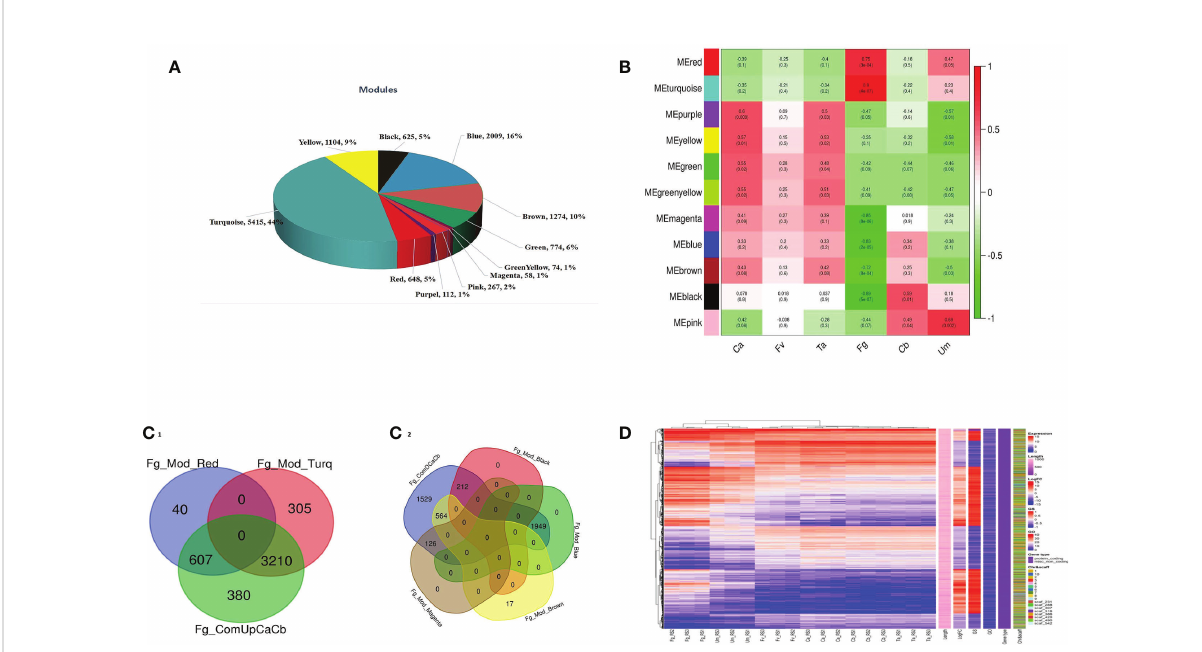
FIGURE 3 WGCN analysis of differentially expressed genes (DEGs) between control A and B of datasets. (A) Range of gene distributions per module. (B) Correlation coef fi cients between modules and samples. Red to green color depicted levels of positive and negative regulation of the genes, respectively. (C) The intersection between signi fi cant DEGs and module genes. Upregulated/positive correlation (C1); downregulated/ negative correlation (C2). (D) Complex heat map of core genes (color codes have different